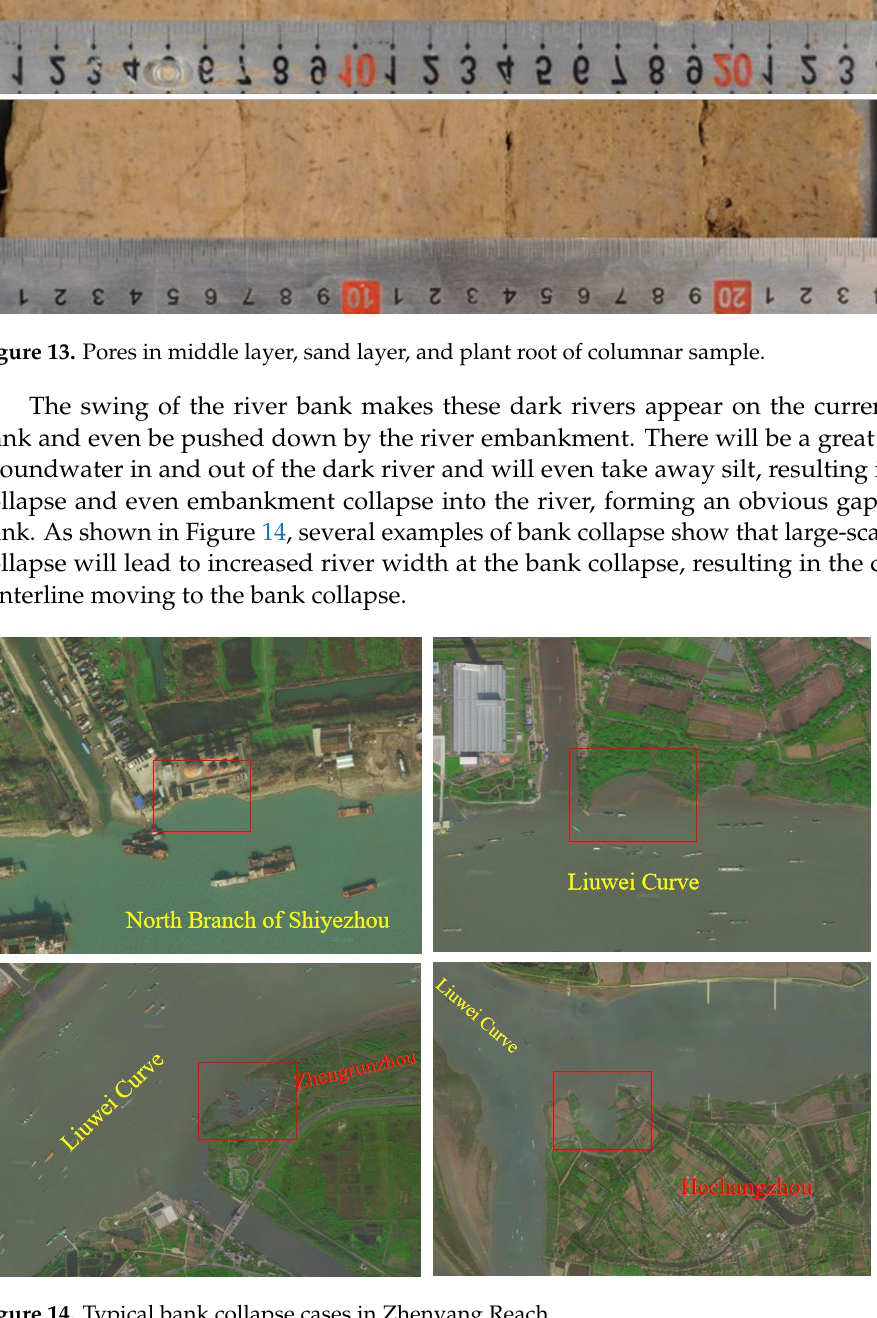
Figure 14. Typical bank collapse cases in Zhenyang Reach.